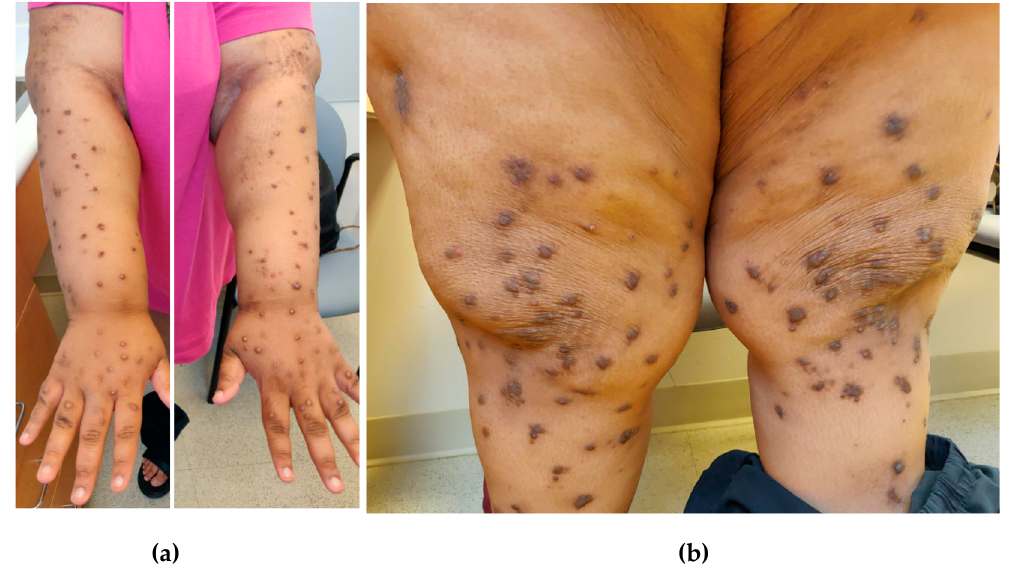
Figure 1. ( a ) Nodules in bilateral distribution on arms and ( b ) legs in a patient diagnosed with prurigo